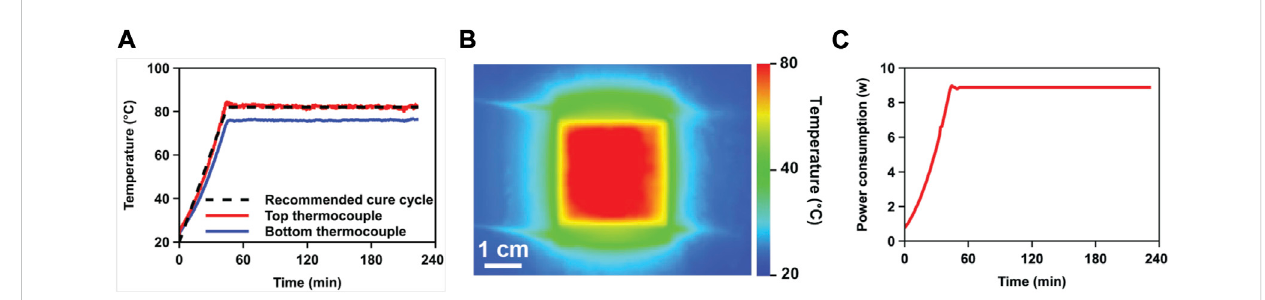
FIGURE 5 Direct conductive curing of a FRPC panel using a nanocomposite fi lm heater. (A) Temperature pro fi les measured at the bottom and top of the composite layup during the cure cycle. (B) Thermal infrared image of the nanocomposite fi lm heater during composite manufacturing. (C) Power consumption pro fi le recorded during the cure